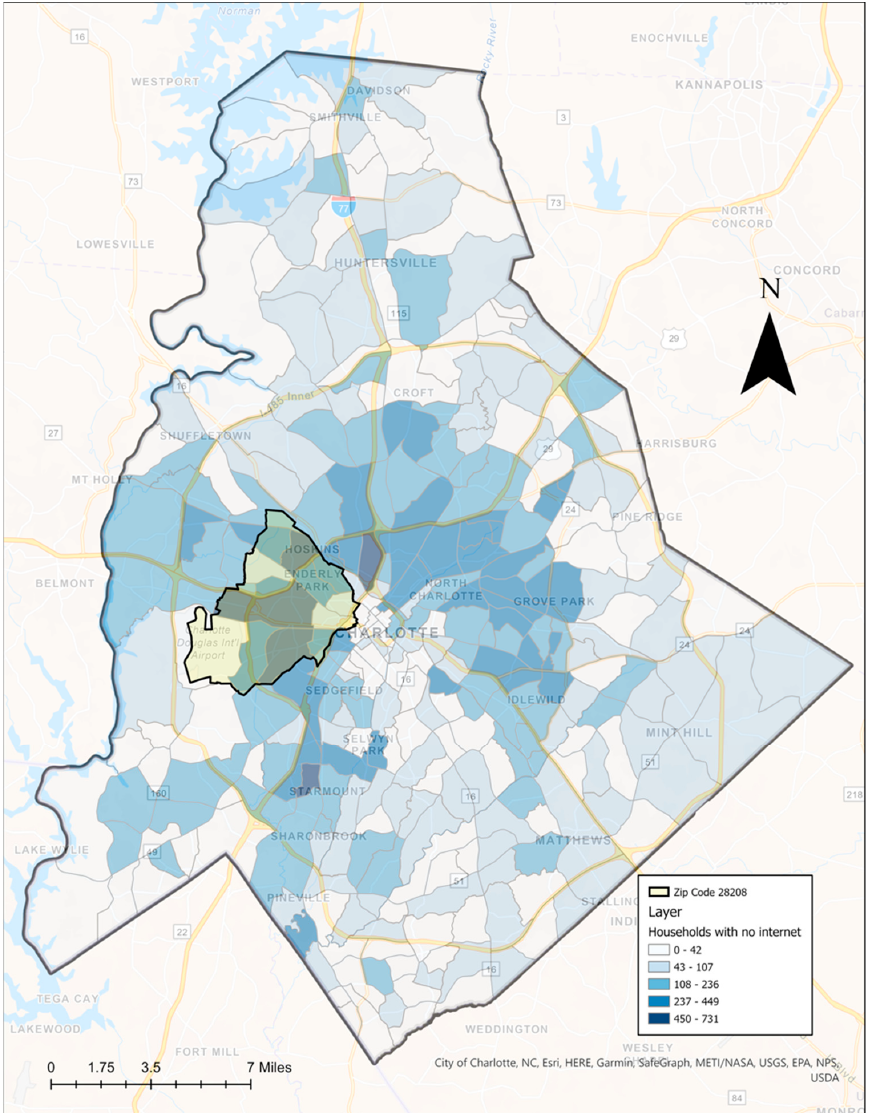
Figure 1. Map of Households Without Internet Access at Home in Mecklenburg County with Emphasis on ZIP Code 28208.